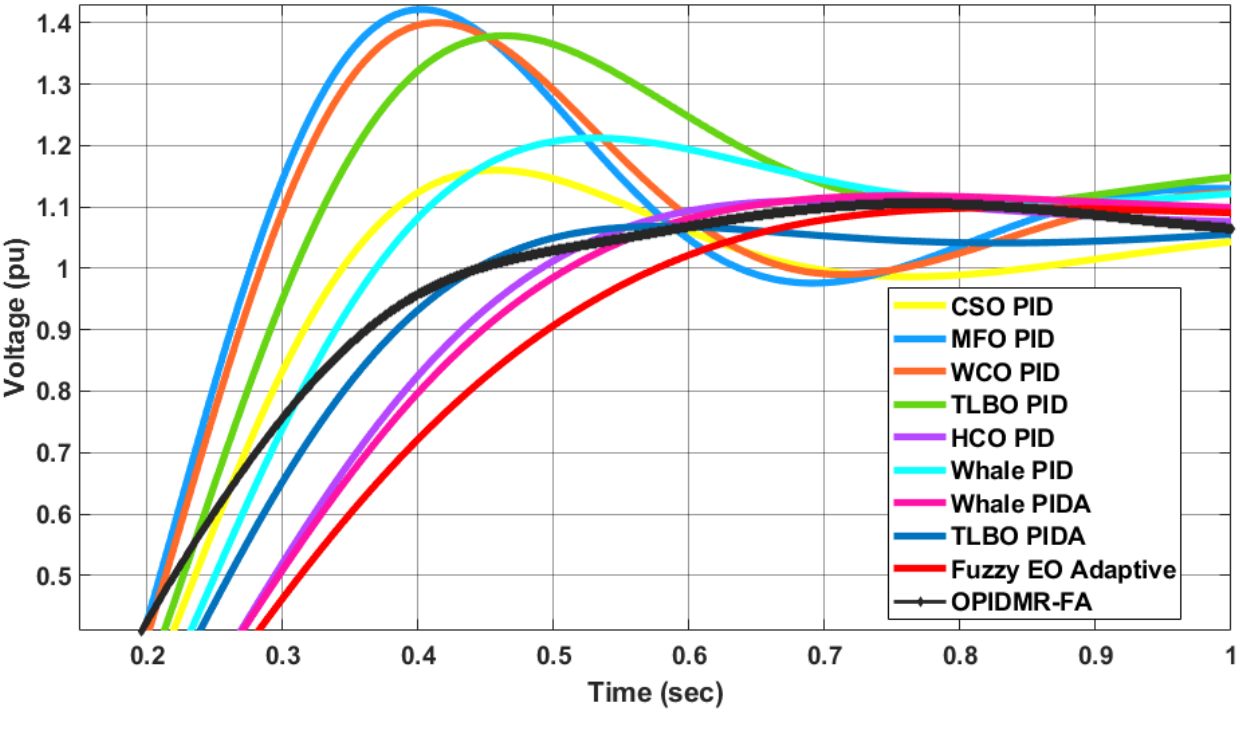
Figure 10. Magnified view of Figure 9.